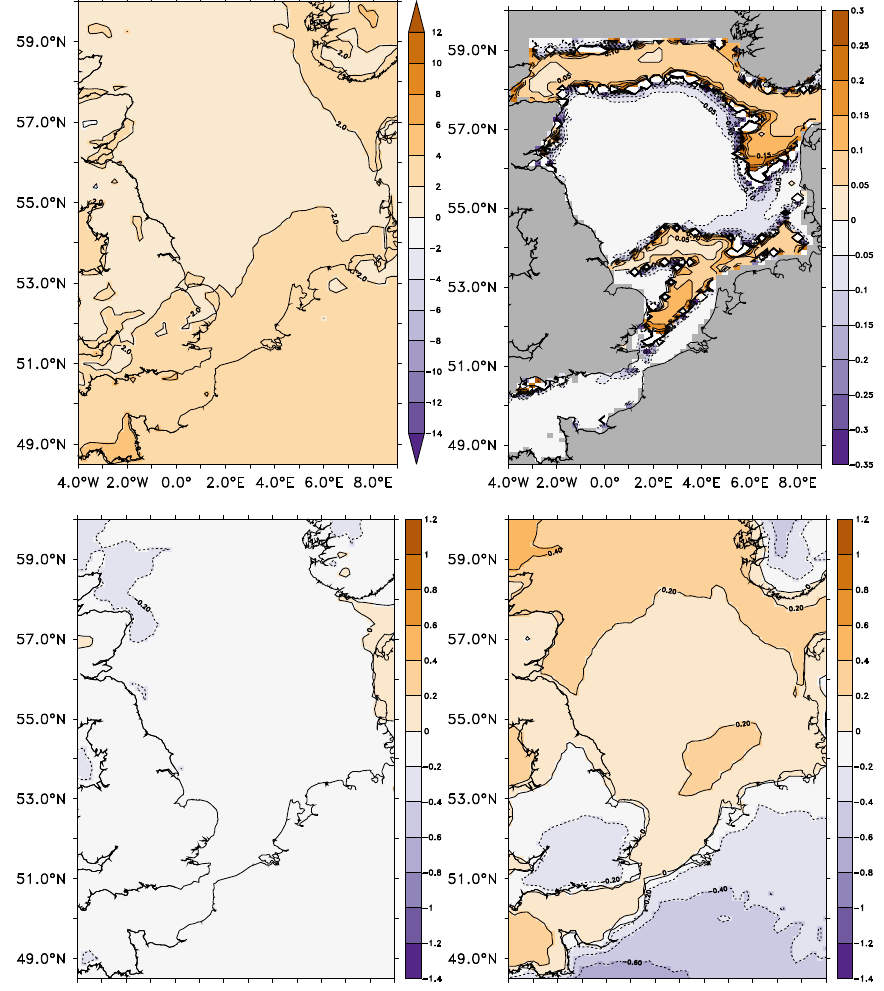
Figure 13. Climatological annual mean changes in radiative heat flux (W/m 2 ) ( upper left ), reciprocal efficiency of vertical heat exchange (m 2 ◦ C/W) ( upper right ), 10 m wind speed (m/s) ( lower left ), and 2 m dew point temperature ( ◦ C) ( lower right ) of the RCA4-NEMO RCP8.5 ensemble mean between periods P2 and